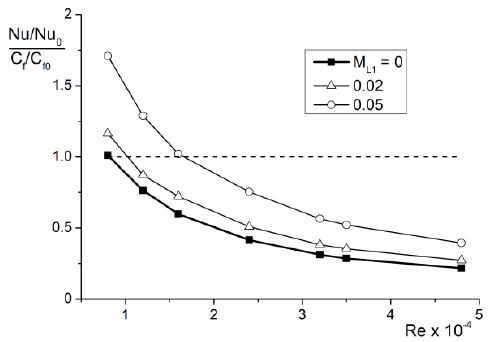
Figure 11. The effect on the thermal hydraulic performance parameter of the Reynolds number of the gas flow and the mass fraction of the dispersed phase at the inlet. d 1 = 15 µm.